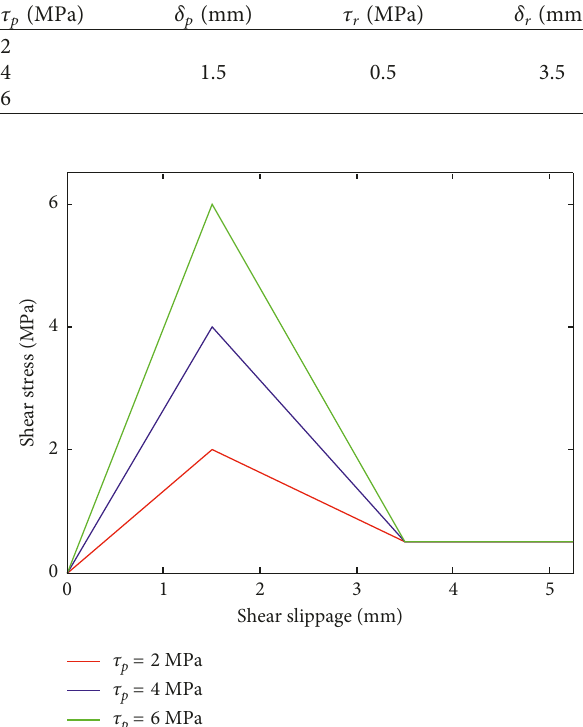
Figure 11: A plot of the input bond-slip model when the shear strength of the bolt/grout interface was different.